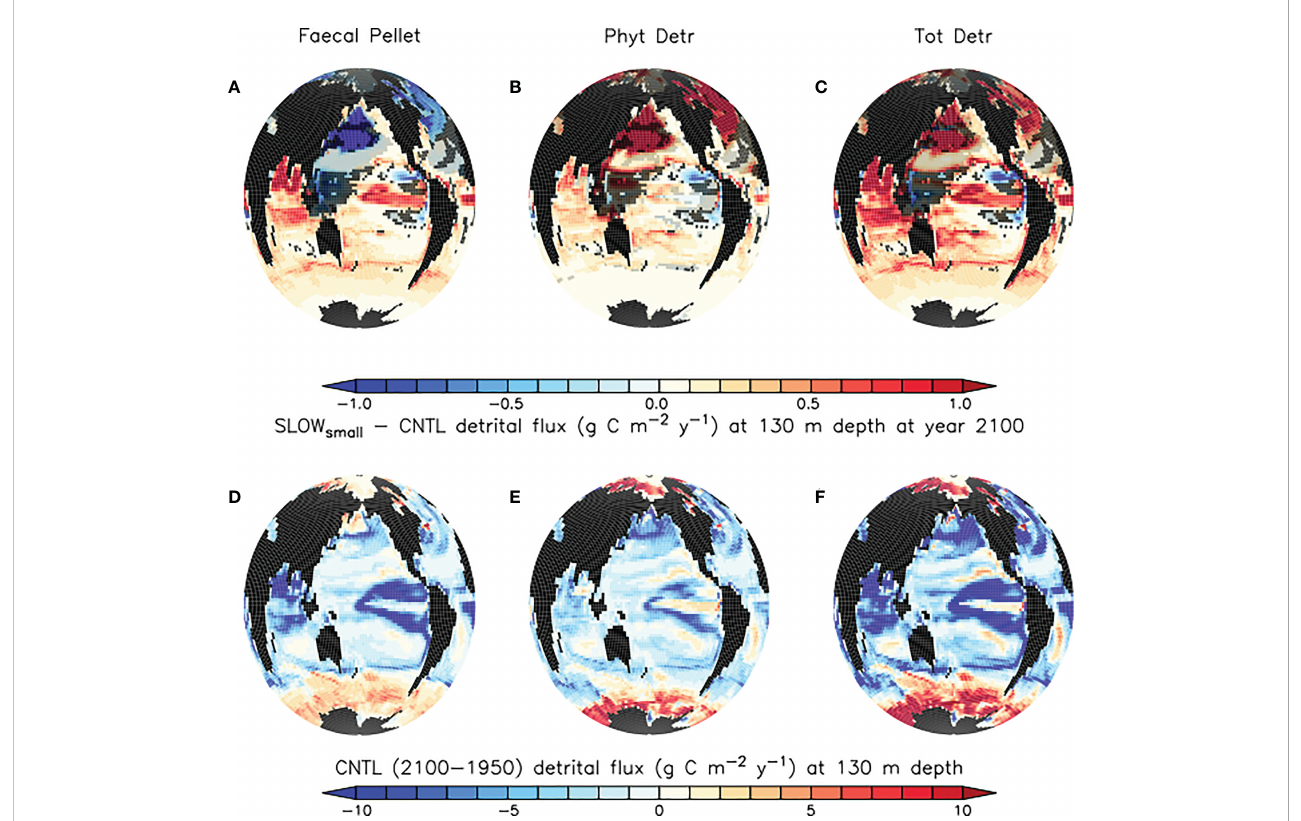
FIGURE 4 (A – C) model ensemble mean differences (SLOW small - CNTL) in simulated organic particle fl ux at 130 m depth at the year 2100. Trends in regions shaded in light grey are not robust (see de fi nition in the text). Trends in regions shaded dark grey do not agree in sign across the model ensemble. Panels (D – F) CNTL model ensemble organic particle fl ux change between years 1950 and 2100 at 130 m depth. Differences in SLOW big - CNTL are generally larger and are provided as Supplemental Figure